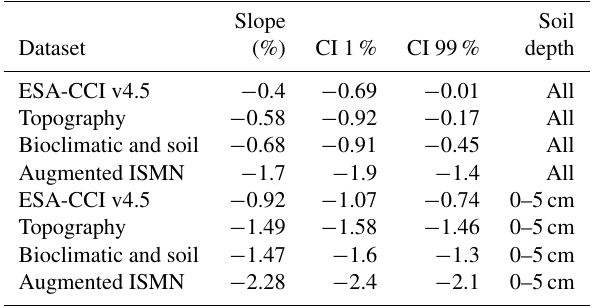
Table 1. The slope and slope uncertainties of soil moisture trends at the locations where all datasets exist. We show the dataset, the slope (%), and the lower and upper confidence interval (CI). We report negative trends considering all available data across all soil depths ( n = 2185 stations) and across sites with information available only between 0–5cm of soil depth ( n = 987